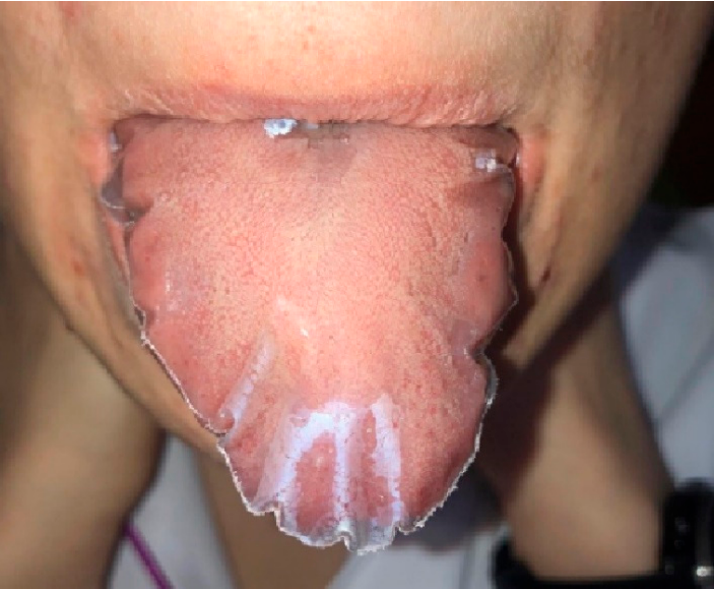
Figure 1. Patient with tongue